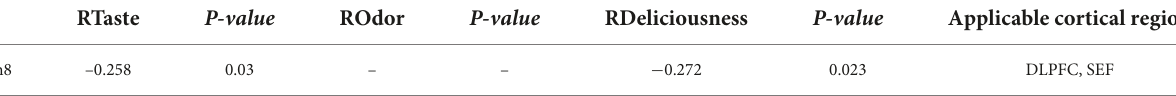
TABLE 2 The correlations between subjective evaluations and hemodynamic responses.